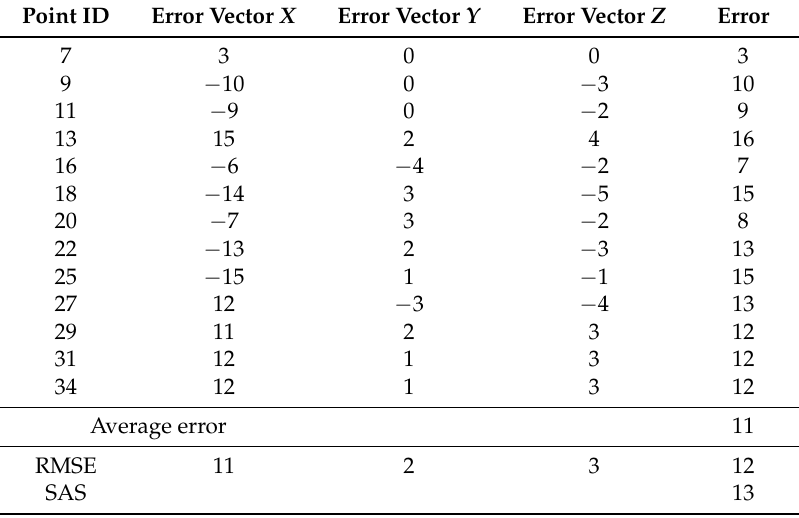
Table 2. Accuracy assessment result for photogrammetry data measured from 3 m to measured object (unit: